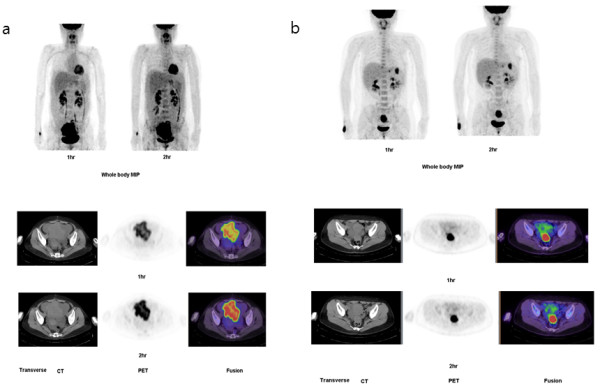
The PET/CT images taken 1 h and 2 h after 18F-FDG injection in a patient with ovarian cancer with peritoneal carcinomatosis (a) and pelvic tuberculosis (b). (a) Whole body MIP image (upper). Axial image showed that FDG uptake at 2 h was significantly increased than FDG uptake at 1 h (lower) (b) Whole body MIP image (upper). Axial image showed almost no change of FDG uptake between at 2 h and at 1 h (lower). MIP = multiple intensity projection.